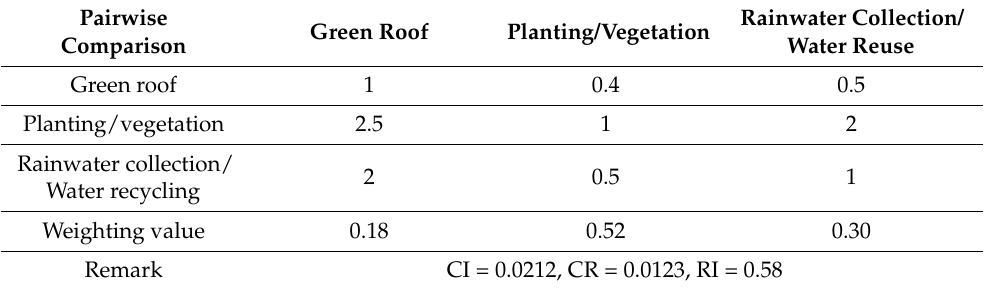
Table 4. Pairwise comparison of relative weights of factors at level 2-2.